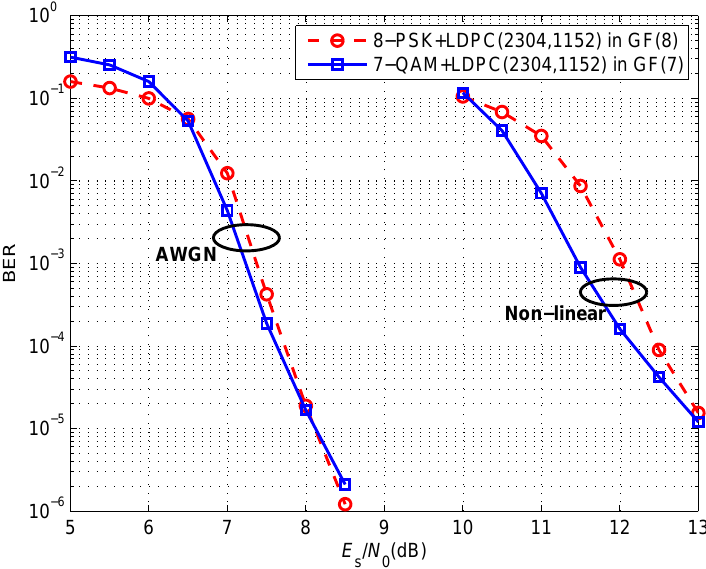
Figure 10. BER of different modulations combined with NB-LDPC codes over different